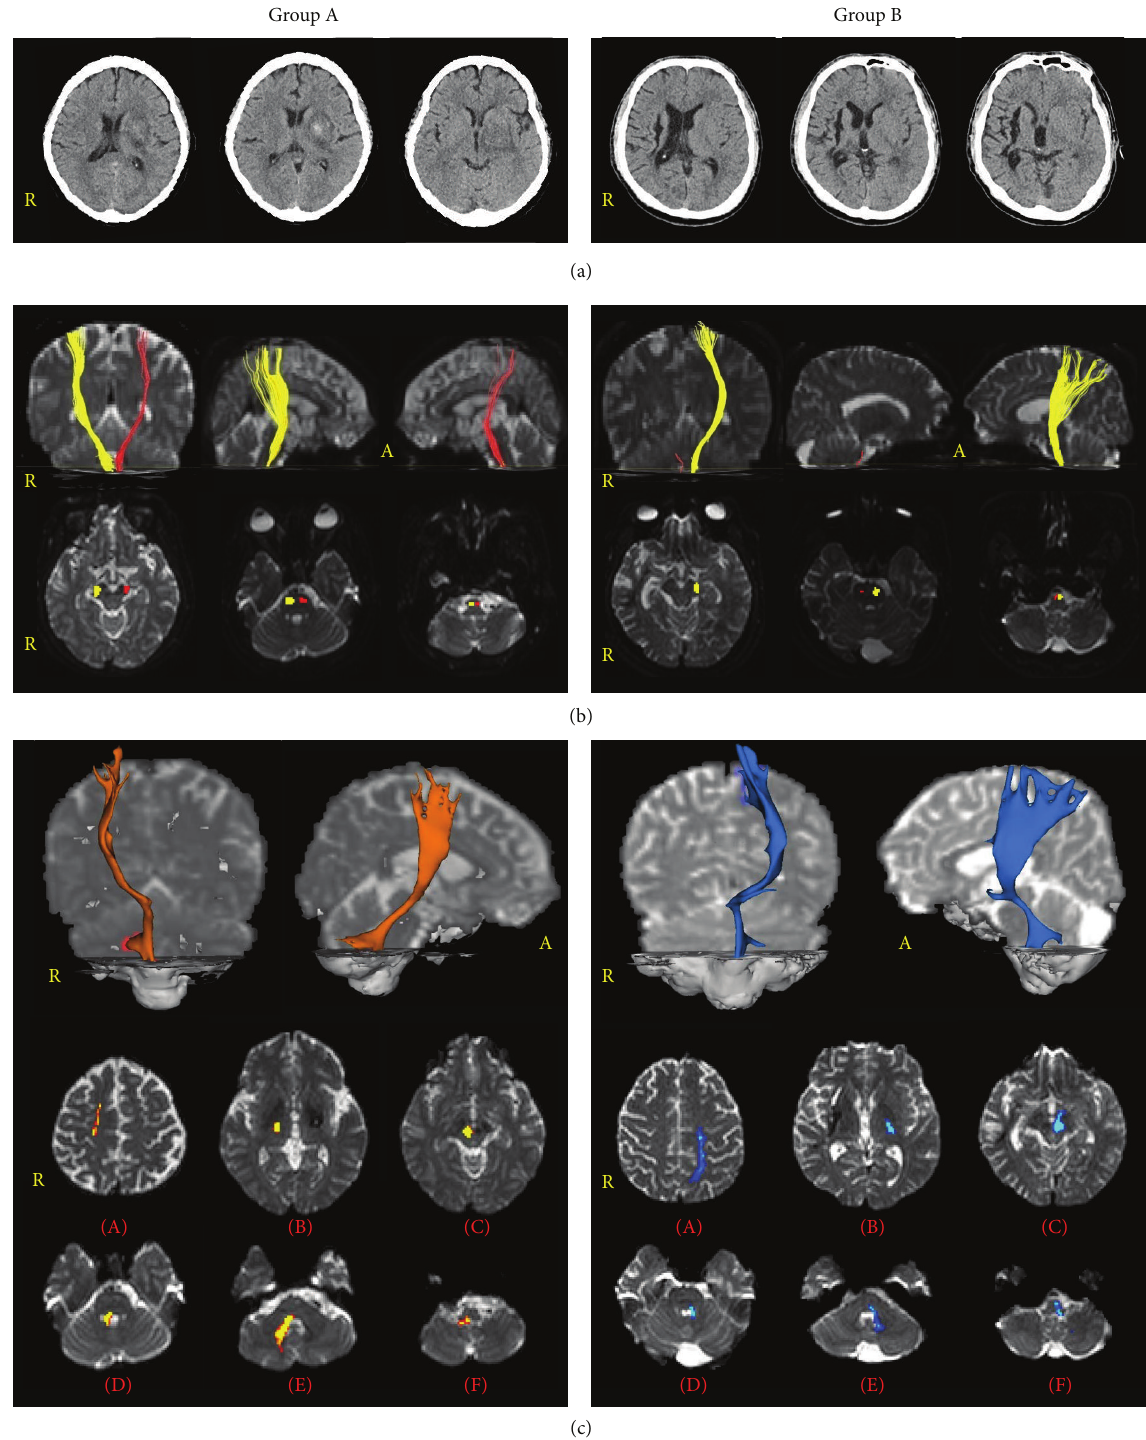
Figure 1: According to diffusion tensor tractography (DTT) findings of the corticospinal tracts (CST) based on integrity, all patients are classified according to two groups: group A, the CST in the affected hemisphere showing preservation of integrity from the cortex to the medulla, and group B, the CST in the affected hemisphere showing a discontinuation of integrity due to the lesion. (a) Brain CT images show the striatocapsular hemorrhage. (b) Results of DTT for the CST (yellow: unaffected hemisphere, red: affected hemisphere) and pathways of CST at the level of brainstem. CSTs descend the basis of pontine and terminate the pyramid of medulla. (c) Results of DTT for the neural connectivity between red nucleus and target brain regions ((A): cortex level, (B): internal capsule level, (C): upper midbrain level, (D): upper pons level, (E): lower pons level, and (F): medullar